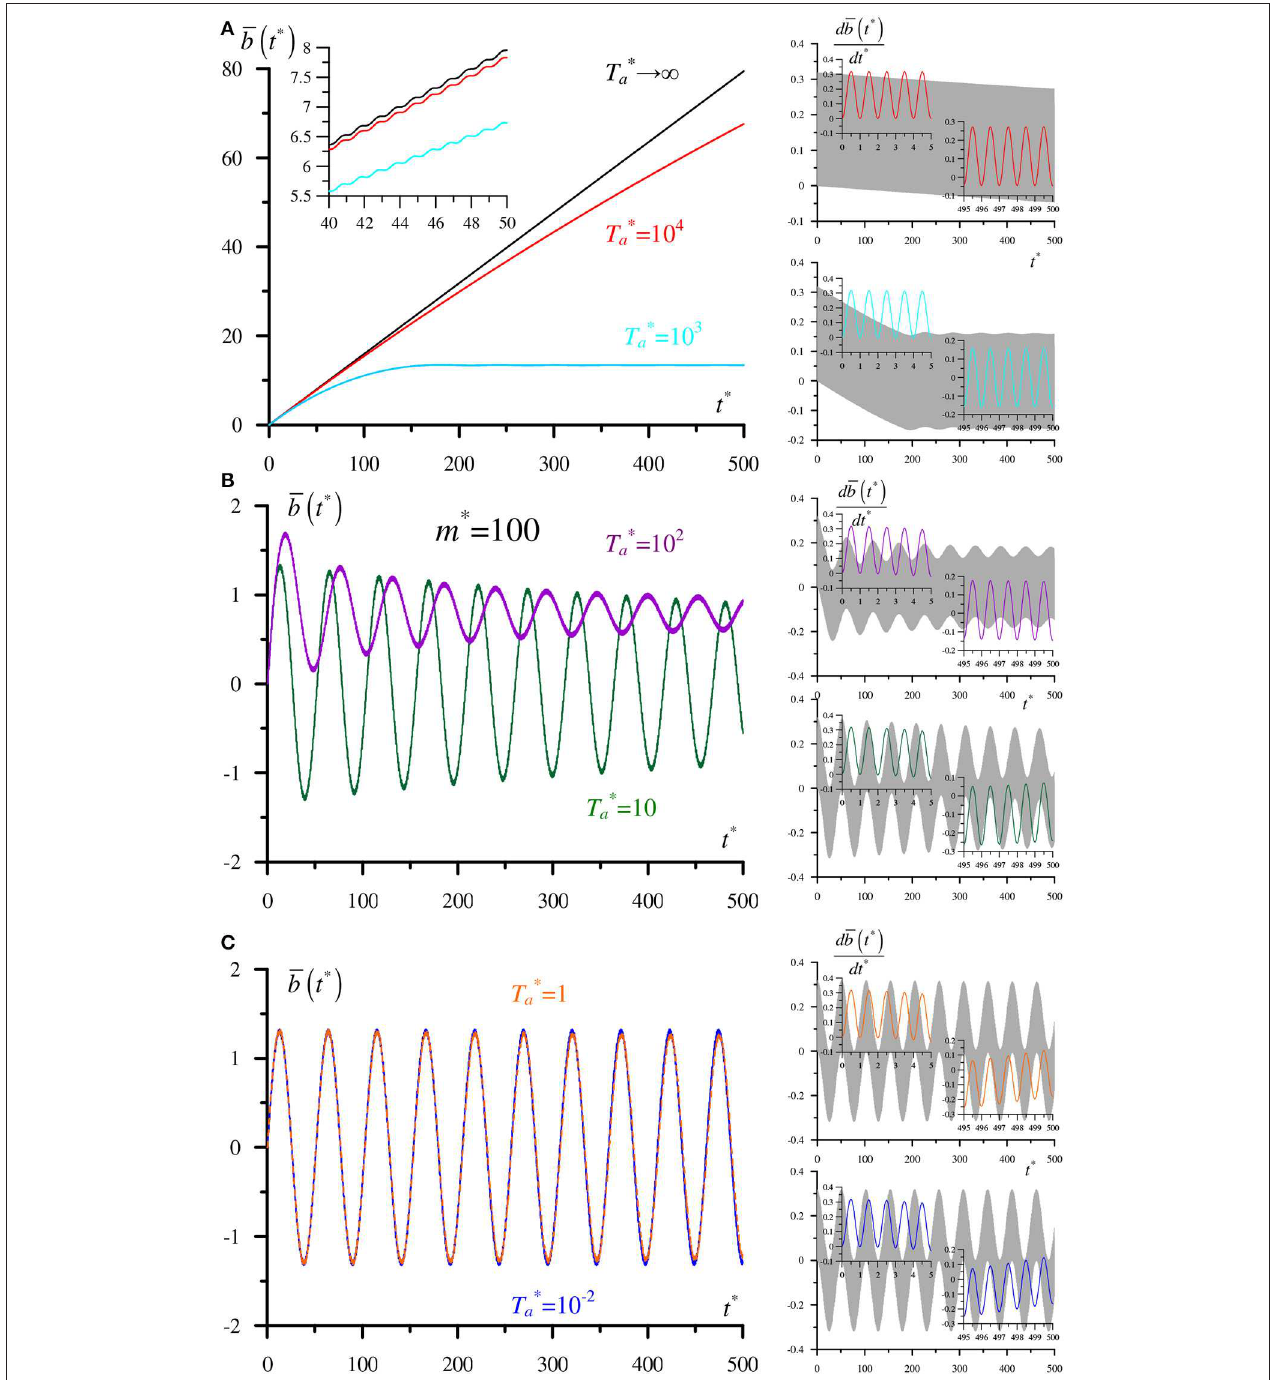
FIGURE 8 | Normalized tangential displacement (at the left) and corresponding velocity (at the right) for different excitation amplitudes T ∗ a for m * = 100: (A) T ∗ a → ∞ , T ∗ a = 10 4 , and T ∗ a = 10 3 ; (B) T ∗ a = 10 2 and T ∗ a = 10; (C) T ∗ a = 1 and T ∗ a = 10 − 2